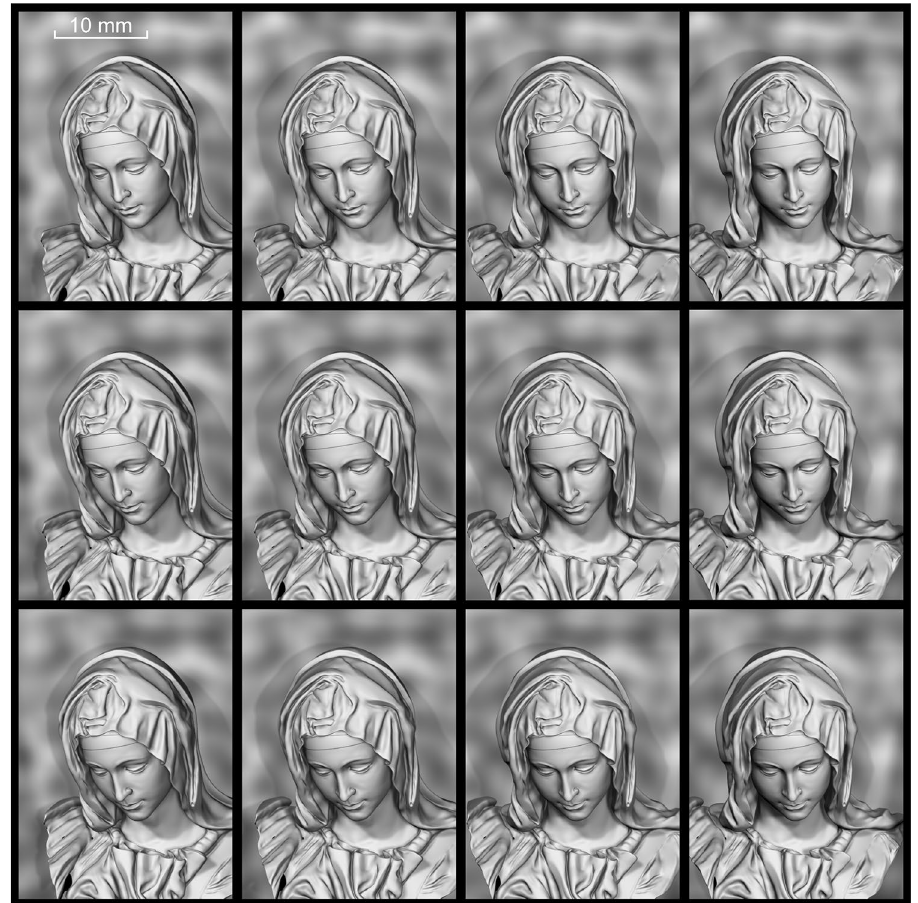
Figure 12. Fragment of the 2D-frames of the 3D-object.